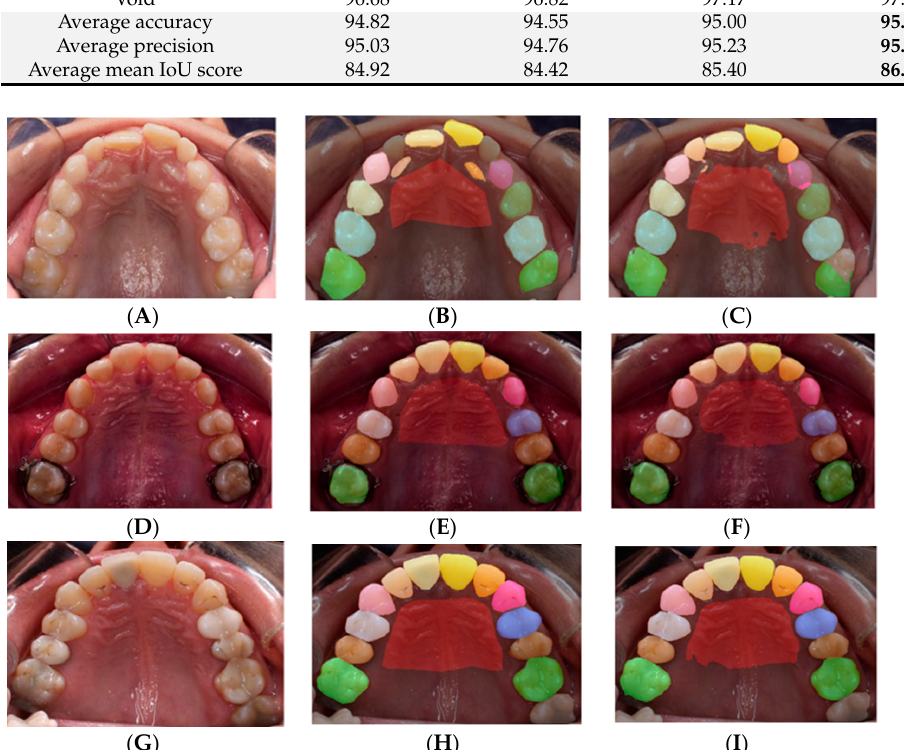
Table 3. Model architecture comparison on specific tooth labels. Model